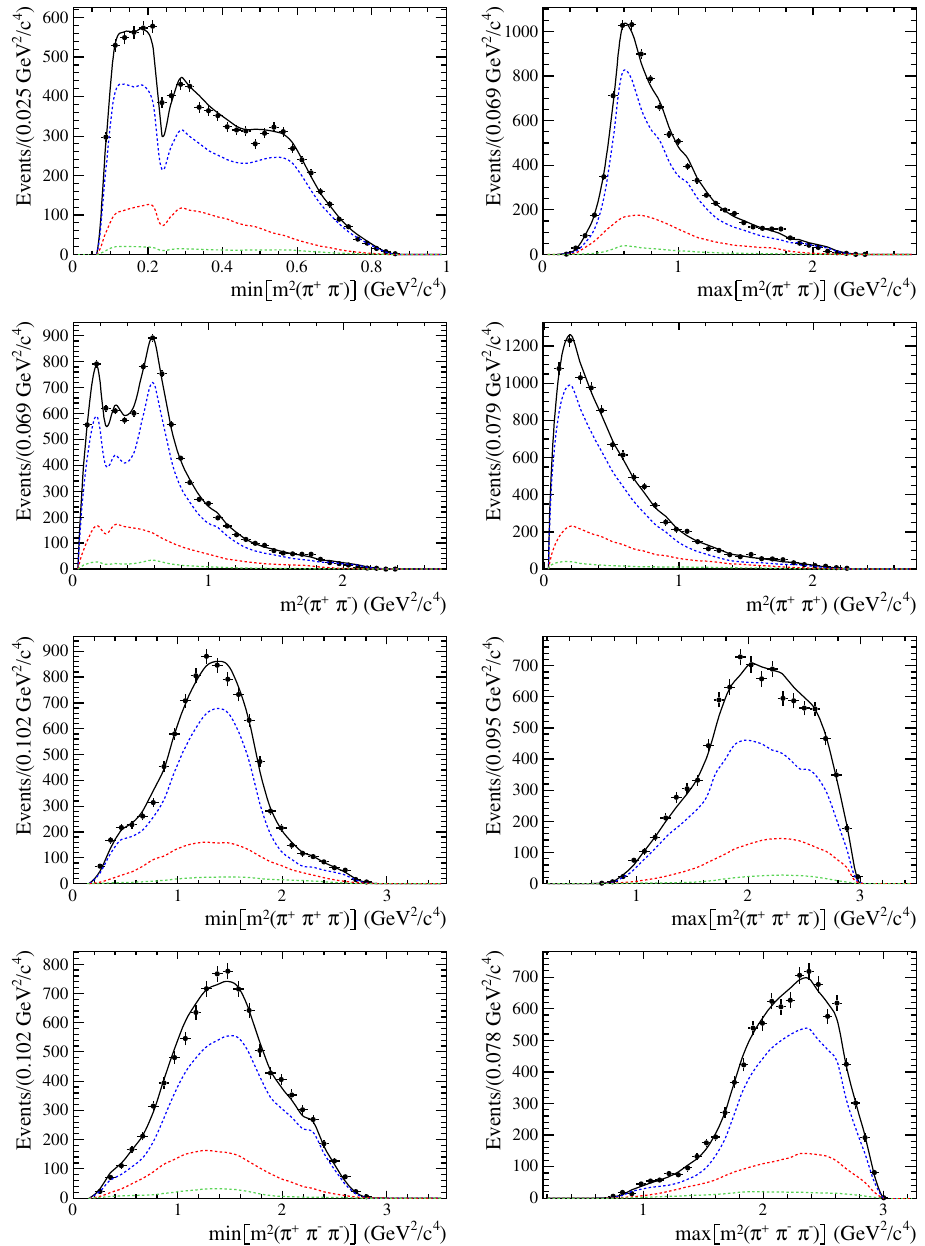
Figure 6 . Invariant mass distributions of D 0 ! (cid:25) + (cid:25) (cid:0) (cid:25) + (cid:25) (cid:0) signal candidates (points with error bars) and (cid:12)t projections (black solid line). The signal component is shown in blue (dashed), the background component in red (dashed) and the wrongly tagged contribution in green (dashed). While the m 2 ( (cid:25) + (cid:25) (cid:0) ) includes all four possible (cid:25) + (cid:25) (cid:0) combinations, the min[ m 2 ( (cid:25) + (cid:25) (cid:0) )] (max[ m 2 ( (cid:25) + (cid:25) (cid:0) )]) distribution includes the two (cid:25) + (cid:25) (cid:0) combinations with the lowest (highest) in- variant mass. The min[ m 2 ( (cid:25) + (cid:25) (cid:6) (cid:25) (cid:0) )] (max[ m 2 ( (cid:25) + (cid:25) (cid:6) (cid:25) (cid:0) )]) distribution includes the (cid:25) + (cid:25) (cid:6) (cid:25) (cid:0) com- bination with the lowest (highest) invariant mass. The e(cid:11)ect of the K 0 veto can clearly be seen in S the top left